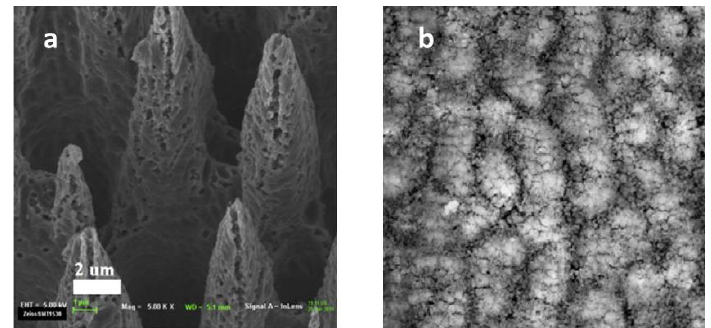
Figure 4. SEM image of black silicon fabricated by femtosecond laser irradiation in corrosive gas or air. ( a ) Corrosive gas atmosphere. Adapted from reference [37], with permission from Elsevier © 2020. ( b ) Air atmosphere. Adapted from reference [10], with permission from Elsevier © 2020.